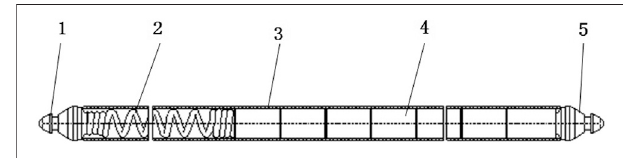
FIGURE 1 | Schematic diagram of fuel